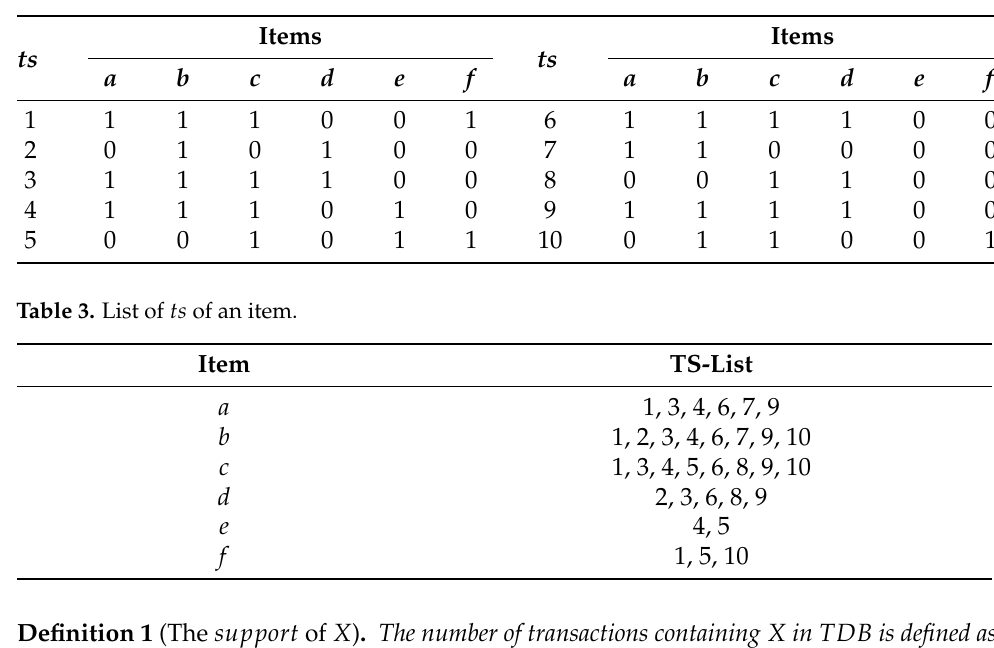
Table 2. Columnar database.